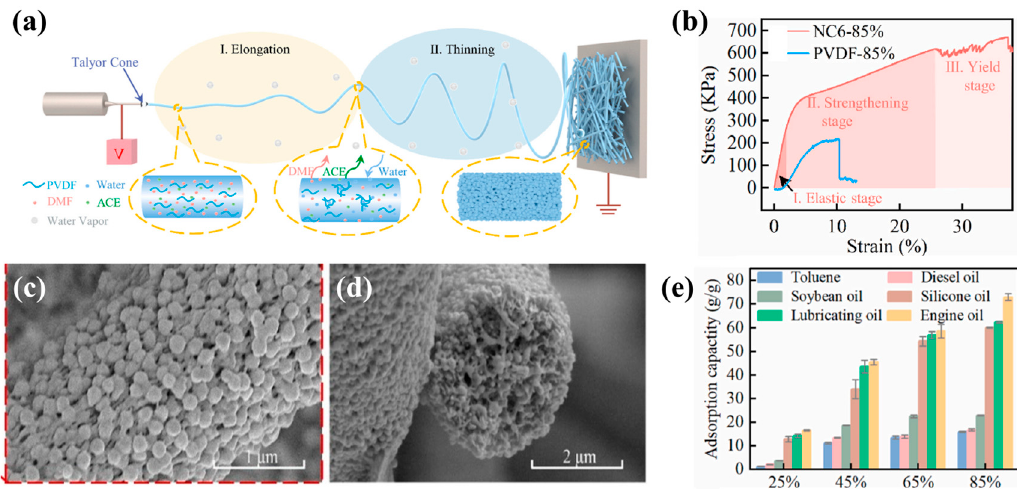
Figure 7. ( a ) Schematic diagram of electrospinning preparation of porous PVDF/CNC nanospheres; ( b ) stress–strain curve of porous PVDF/CNC and pure PVDF membranes; ( c , d ) SEM images of electrospun porous nanofibers with relative humidity of 85%; ( e ) adsorption capacities of porous PVDF/CNC membrane to different oils in different humidity. Reprinted with permission from Ref. [142], Copyright 2022,